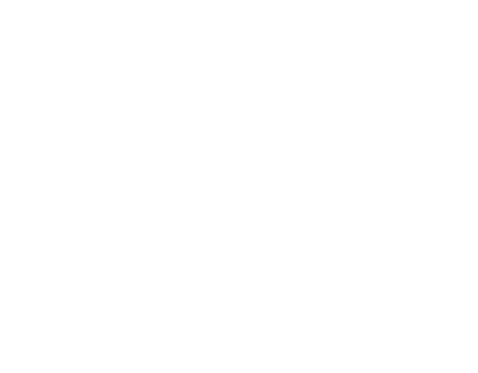
Figure 13. Schematic diagram of the test sample with a structural plane 72